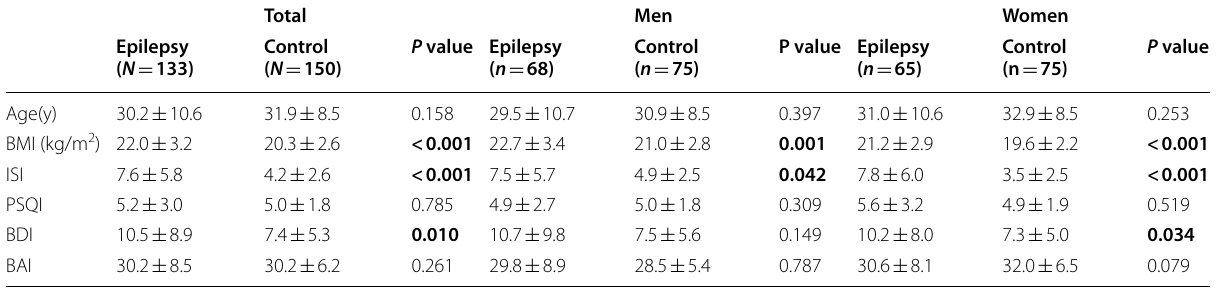
Data are presented as counts (%) or mean The p -Values are obtained from independent-sample t-test and Mann-Whitney U test